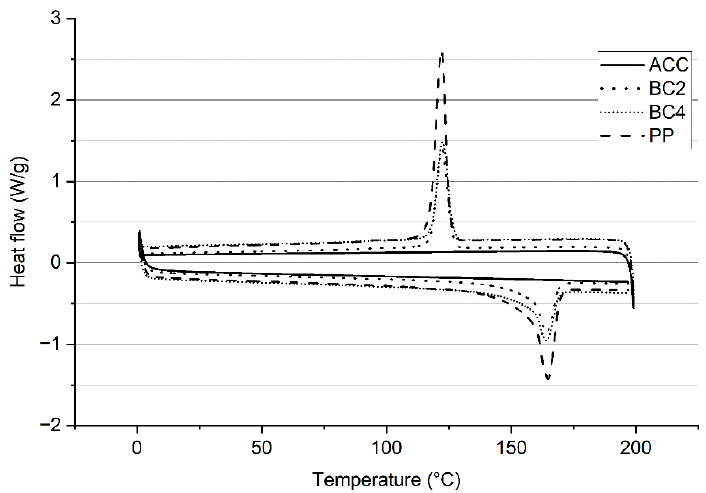
Figure 7. Results of DSC in a range between 0 °C and 200 °C for all-cellulose composites (ACC), biocomposites (BC2 and BC4) and polypropylene (PP).